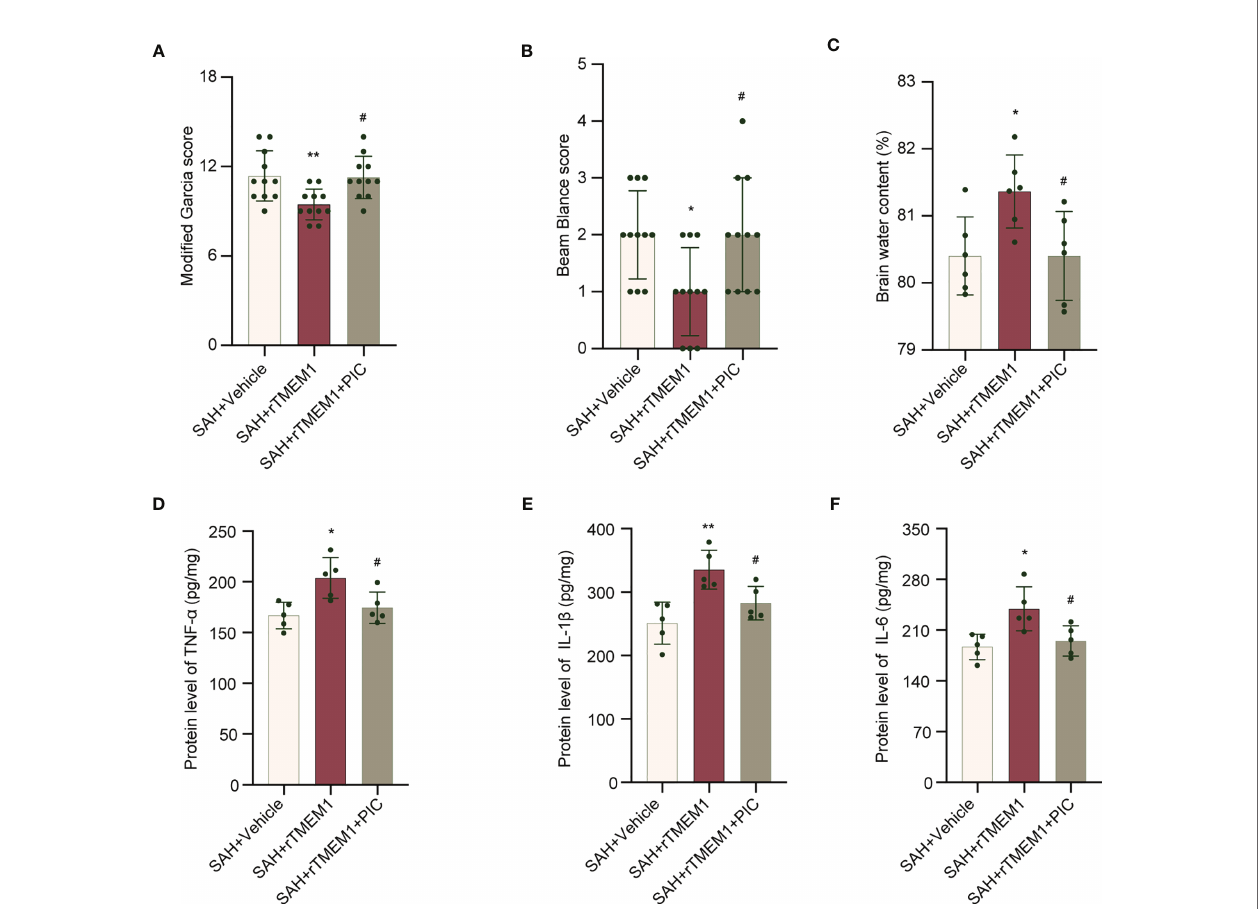
FIGURE 9 | SYK inhibitor piceatannol reversed the aggravation of neurological de fi cits, brain edema, and in fl ammation induced by rTREM-1. (A, B) Quanti fi cation of neurological function (modi fi ed Garcia score and beam balance test) at 24 h after SAH. n = 11/group. (C) Quanti fi cation of brain water content. n = 6/group. (D – F) Relative mRNA levels of in fl ammatory marker genes (TNF- a , IL-1 b , IL-6). n = 5/group. Data are expressed as mean ± SD. *P < 0.05, **P < 0.01 vs SAH+ vehicle group; # P < 0.05 vs SAH+rTREM1